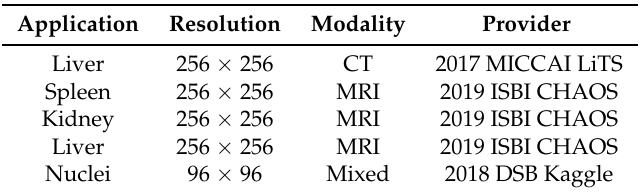
Table 1. An overview of some important information of the medical image datasets used in this experiment. Application